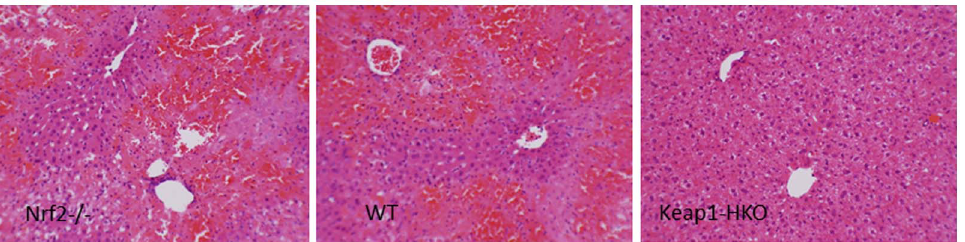
Figure 2. Histological analysis of livers from Nrf2-null, wild-type, and Keap1-HKO mice treated with microcystin (50 m g/kg, i.p.). H & E staining with magnification (200 6 ).